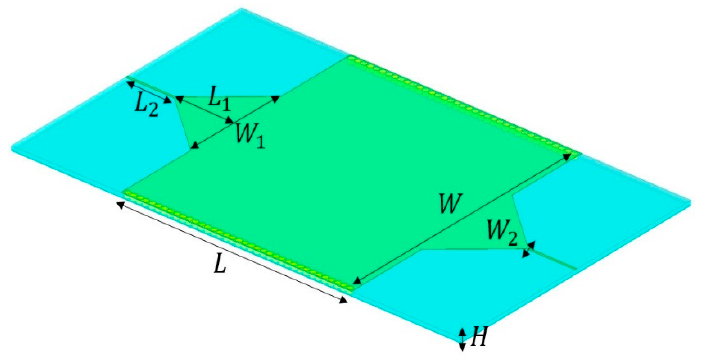
Figure A1. SIW example with tapered transition.